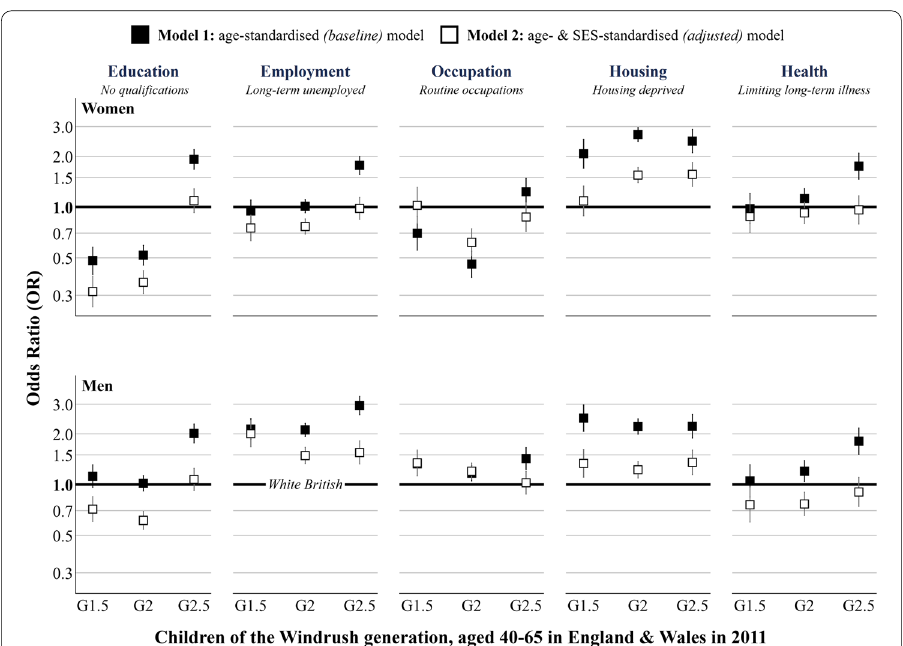
Fig. 1 Summary panel of logistic regression models for negative outcomes in the five life domains for the children of the Windrush relative to White British population resident in 2011. Notes Baseline models adjust age and subpopulation, final models adjust region of residence, civil status, level of highest qualification, NS‑SEC, housing tenure, and self‑reported general health, minus the control relating to the specific domain i.e., we do not adjust for the highest level of qualification if our outcome is having obtained a degree level Source : Authors’ calculations based upon 5% microdata sample of resident population of England and